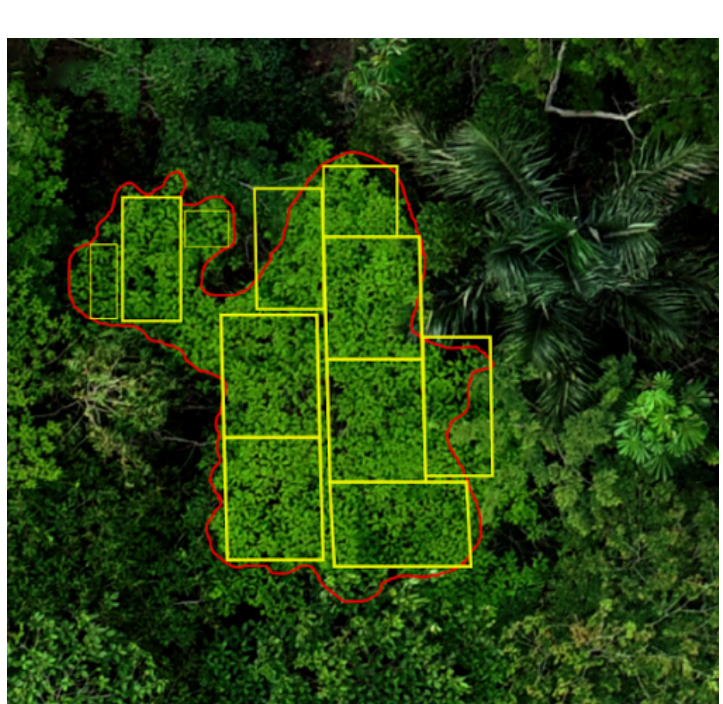
Figure 2. Representation of sample selection in an individual image. The red polygon represents tree canopy ( H. serratifolius ), and the yellow rectangles represent subsamples obtained for this spe- cies.